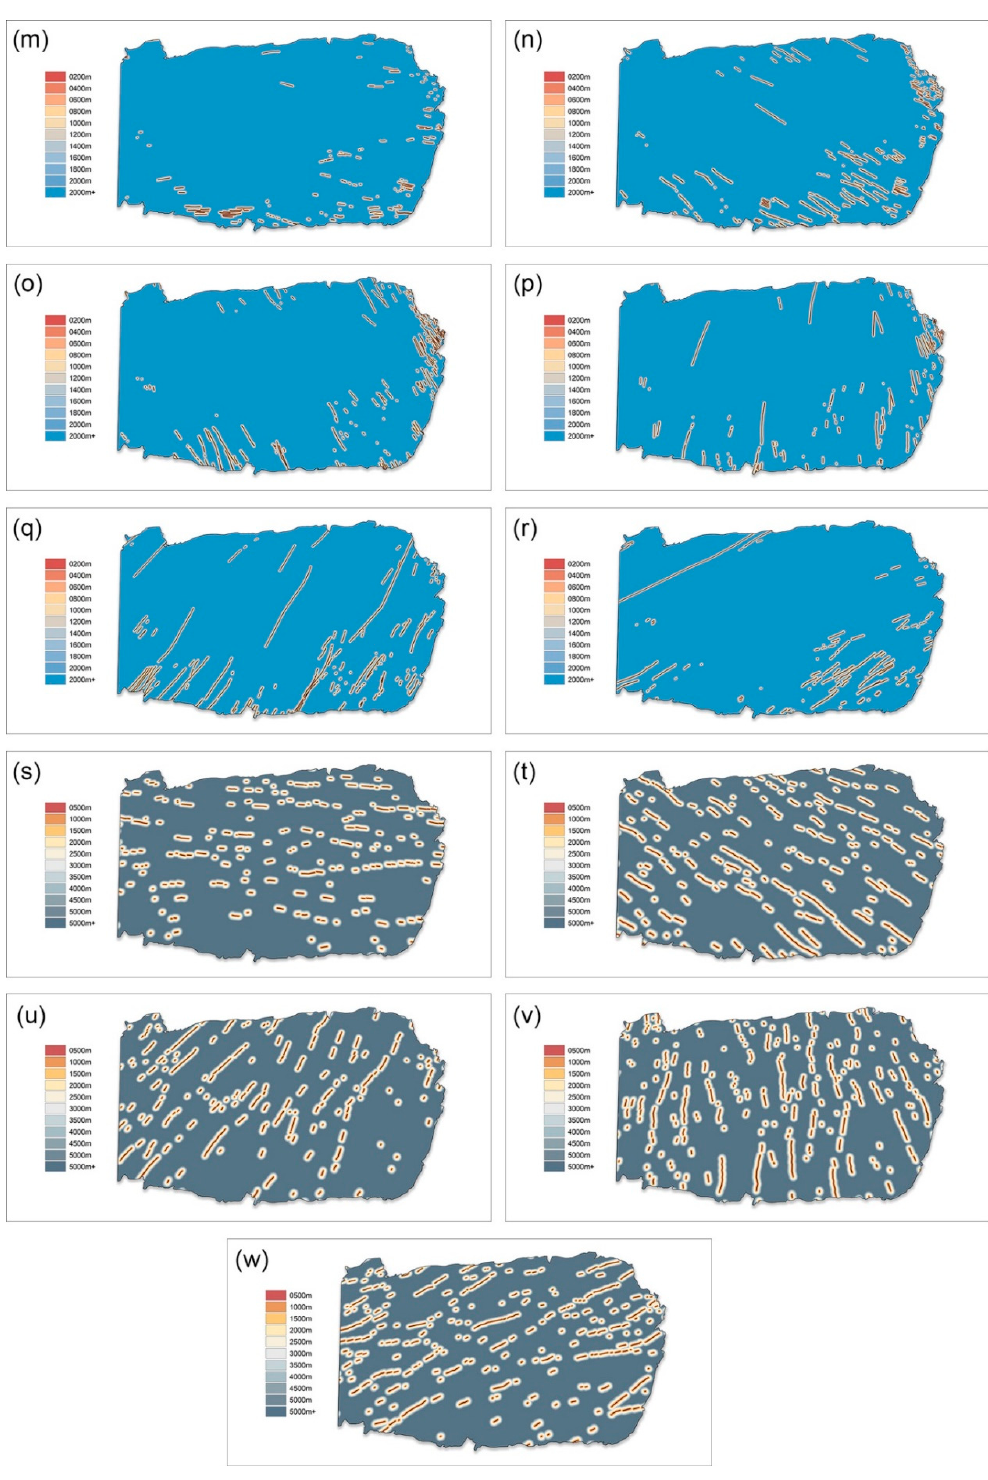
Figure 9. Athabasca Basin predictors: ( a ) solid geology, ( b ) magnetic domains, ( c ) gravity edges 6400 WNW bu ff ered, ( d ) gravity edges 6400 NW bu ff ered, ( e ) gravity edges 6400 NNW bu ff ered, ( f ) gravity edges 6400 NNE bu ff ered, ( g ) gravity edges 6400 NE bu ff ered, ( h ) gravity edges 6400 ENE bu ff ered, ( i ) magnetics 1600 edge density, ( j ) conductors—air, ( k ) conductors—ground, ( l ) Extech IV faults, ( m ) faults WNW bu ff ered, ( n ) faults NW bu ff ered, ( o ) faults NNW bu ff ered, ( p ) faults NNE bu ff ered, ( q ) faults NE bu ff ered, ( r ) faults ENE bu ff ered, ( s ) gravity edges 1600 WNW bu ff ered, ( t ) gravity edges 1600 NW bu ff ered, ( u ) gravity edges 1600 NE bu ff ered, ( v ) gravity edges 1600 NNE bu ff ered and ( w ) gravity edges 1600 ENE bu ff